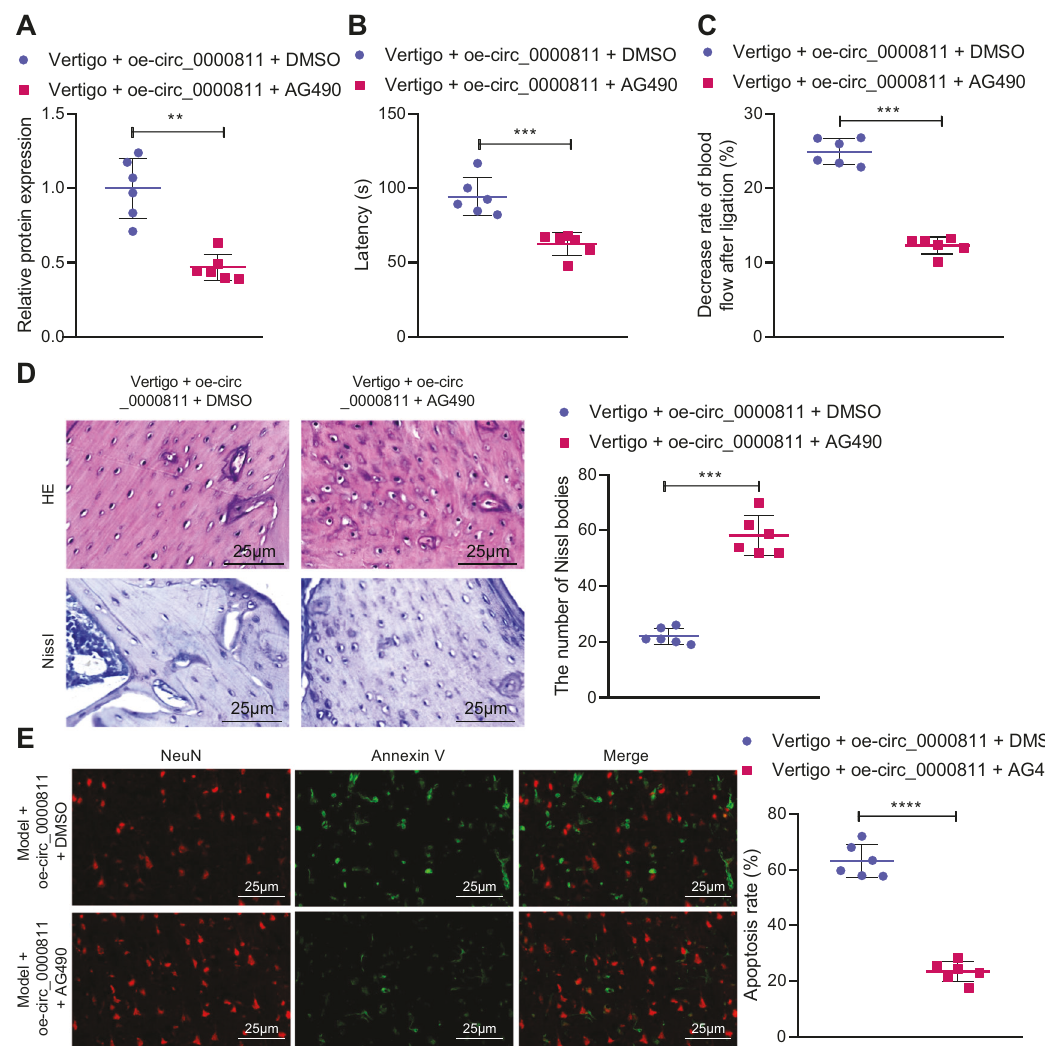
Fig. 6 Circ_0000811 overexpression ameliorated experimental CI-induced vertigo through the miR-15b/Prkar2a/JAK2/STAT1 axis. A Western blot to determine the phosphorylation level of STAT1 in the MVN of mice with CI-induced vertigo overexpressing circ_0000811 with/without AG490 treatment; B the escape latency of mice with CI-induced vertigo overexpressing circ_0000811 with/without AG490 treatment; C the blood fl ow of the MVN after ligation of CCA and SCA in mice with CI-induced vertigo overexpressing circ_0000811 with/ without AG490 treatment; D H&E and Nissl staining to detect the histopathological changes of the MVN in mice with CI-induced vertigo overexpressing circ_0000811 with/without AG490 treatment; E NeuN/Annexin counterstaining staining to detect the neuronal apoptosis in the MVN of mice with CI-induced vertigo overexpressing circ_0000811 with/without AG490 treatment. ** p < 0.01, *** p < 0.001 compared with the Vertigo + oe-circ_0000811 + DMSO group. Independent sample t test was applied for the comparison between two groups. CI cerebral ischemia; Prkar2a, protein kinase, cAMP dependent regulatory, type II alpha, JAK2 Janus kinase 2, STAT1 signal transducer and activator of transcription 1, MVN medial vestibular nucleus, CCA common carotid artery, SCA superior cerebellar artery, H&E hematoxylin and eosin, NeuN neuronal nuclei, AG490 JAK2/STAT1 signaling pathway